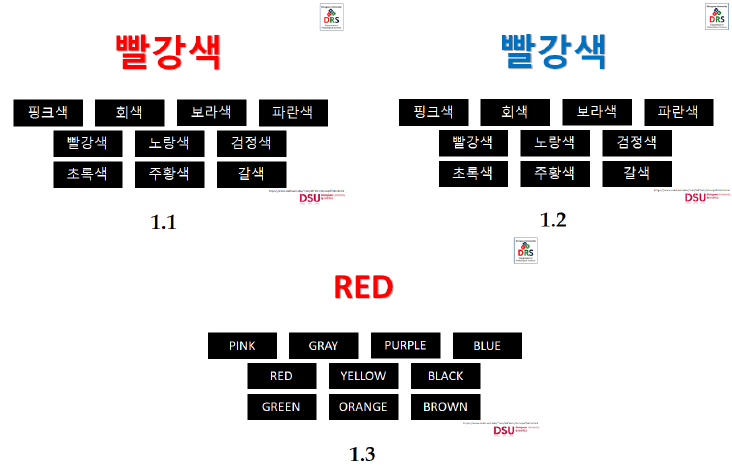
Figure 1. The self-made CWIT. (1.1) CKC-1: In the Korean language; the color word is the same as the ink color ( 빨강색 = red), (1.2) IKC-2: In the Korean language; the color word is different with the ink color, and (1.3) CEC-3: In English language; the color word is the same with the ink color.